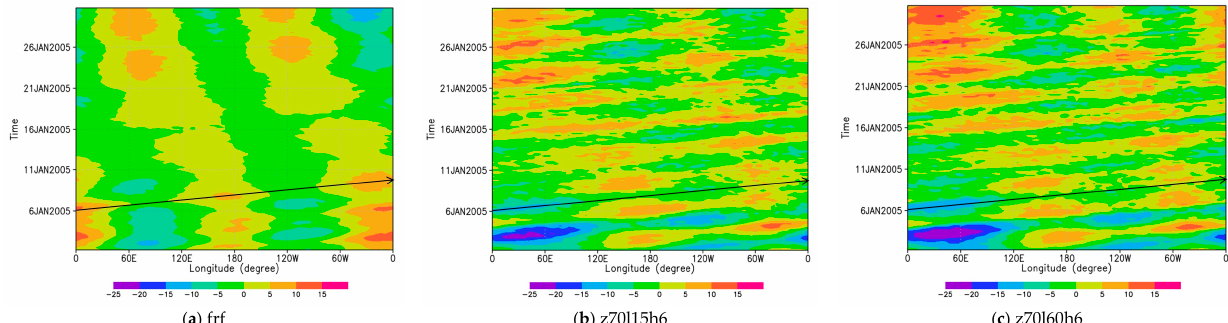
Figure 2. Longitude-time cross sections of zonal wind deviation from its time average at 70 km altitude at the equator from 1 January 2005. Data is not assimilated in ( a ), namely, free run forecast of AFES-Venus, while it is assimilated (analysis) each 6 h at 70 km altitude from 15 ◦ S–15 ◦ N in ( b ) and from 60 ◦ S–60 ◦ N in ( c ). Black arrows indicate almost 4-day phase velocity from bottom left to upper right.